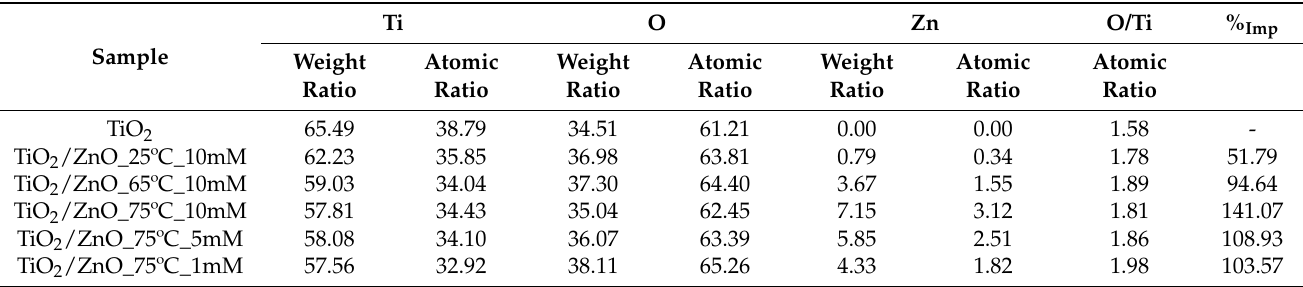
Table 3. EDX results of TiO 2 nanosponges and TiO 2 /ZnO hybrid nanosponges electrodeposited at different temperatures and Zn(NO 3 ) 2 concentrations, and % imp